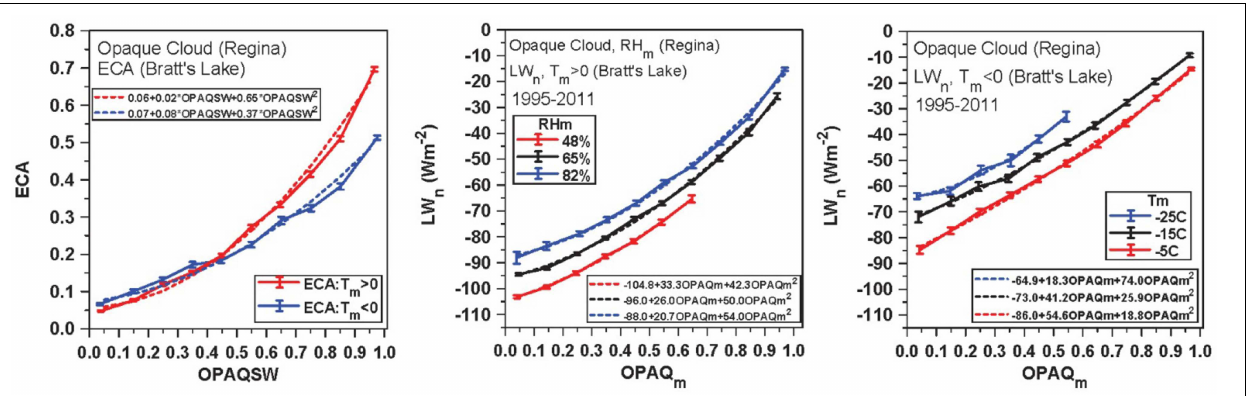
FIGURE 5 | Relation between Opaque cloud at Regina and Bratt’s Lake ECA (left), LW n and stratified by RH m in warm season (middle) and (right) LW n stratified by T m in cold season.